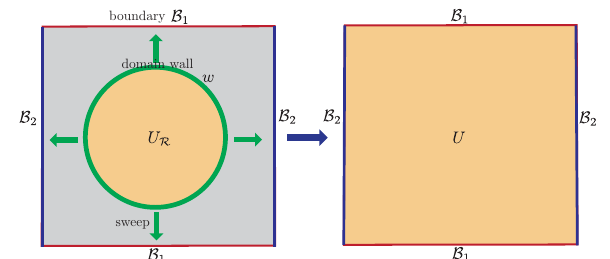
FIG. 25. (a) Both the particle and string (loop) excitations get transformed when passing the codimension-1 domain wall (green) in 3D. (b) A particle excitation cannot be transformed by the codimension-2 domain wall (pink) in 3D, since the particle can generically avoid such a wall. The string (loop) gets trans- formed by the wall only at the intersection point between the string and the wall, where a new particle (purple) is